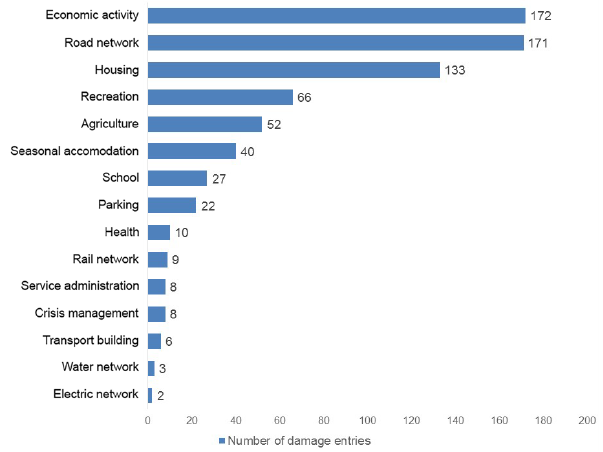
Figure 6. Number of flood-related damage events by type of ele- ment affected since 2011 in the south of France.